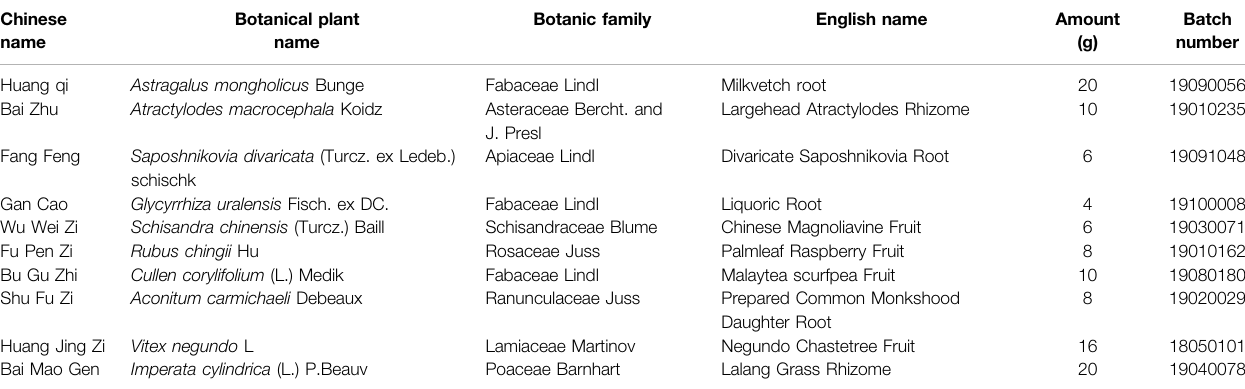
TABLE 1 | Composition and doses of